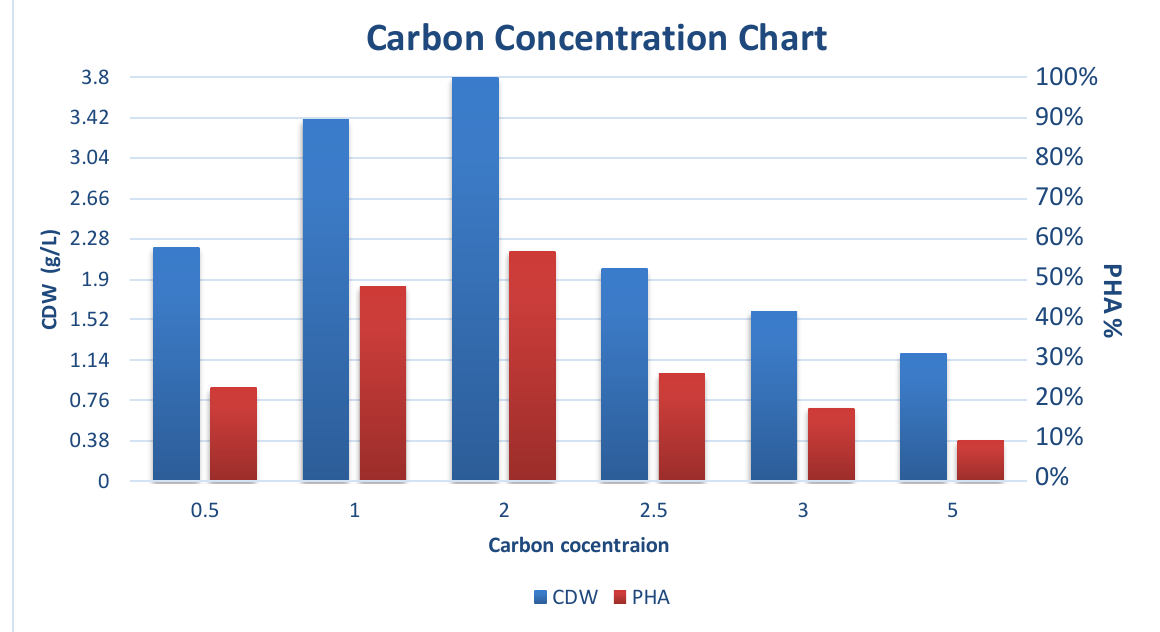
Figure 7: Effect of different carbon source concentrations on bacterial growth and PHA